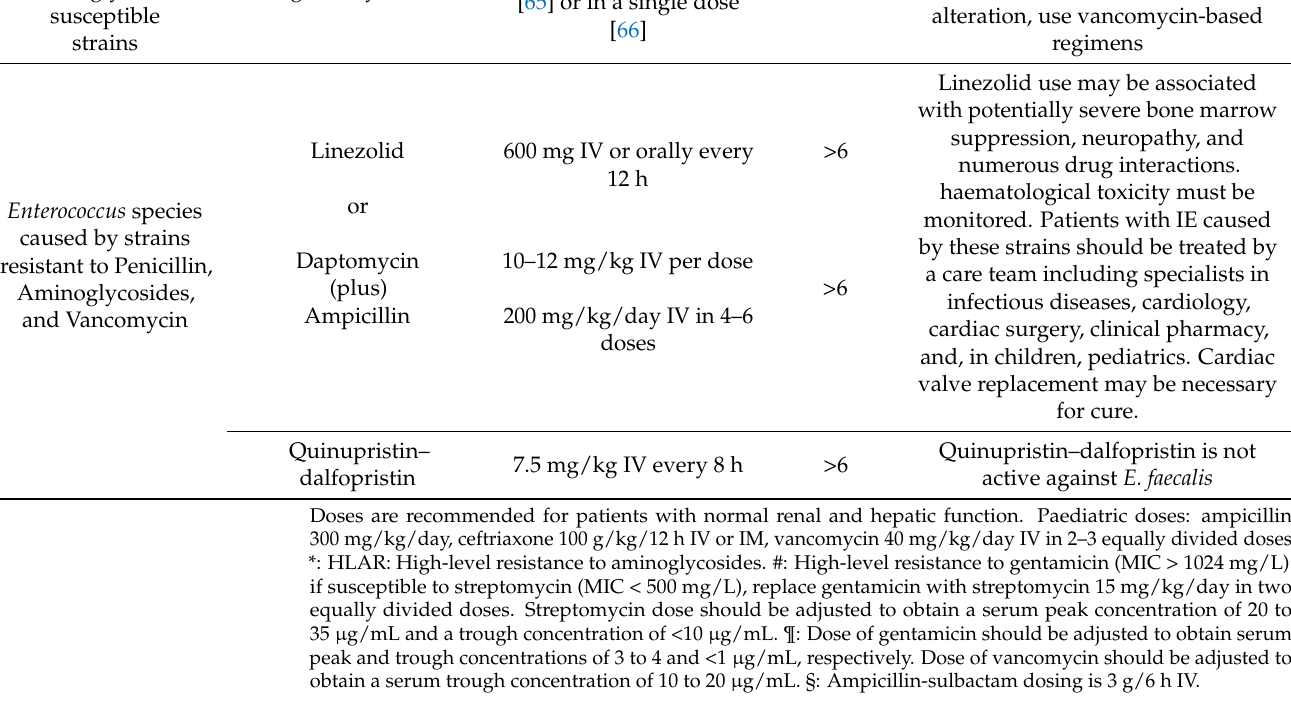
Table 3. Alternatives for treatment in Enterococcus infective